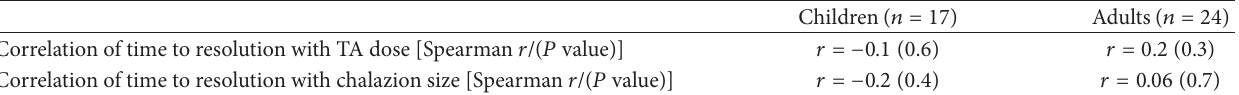
Table 2: Correlations of TA dose and chalazion size with time to resolution in adults and children. Children (𝑛 = 17) Adults (𝑛 = 24) Correlation of time to resolution with TA dose [ Spearman 𝑟 /( 𝑃 value)] 𝑟 = −0.1 (0.6) 𝑟 = 0.2